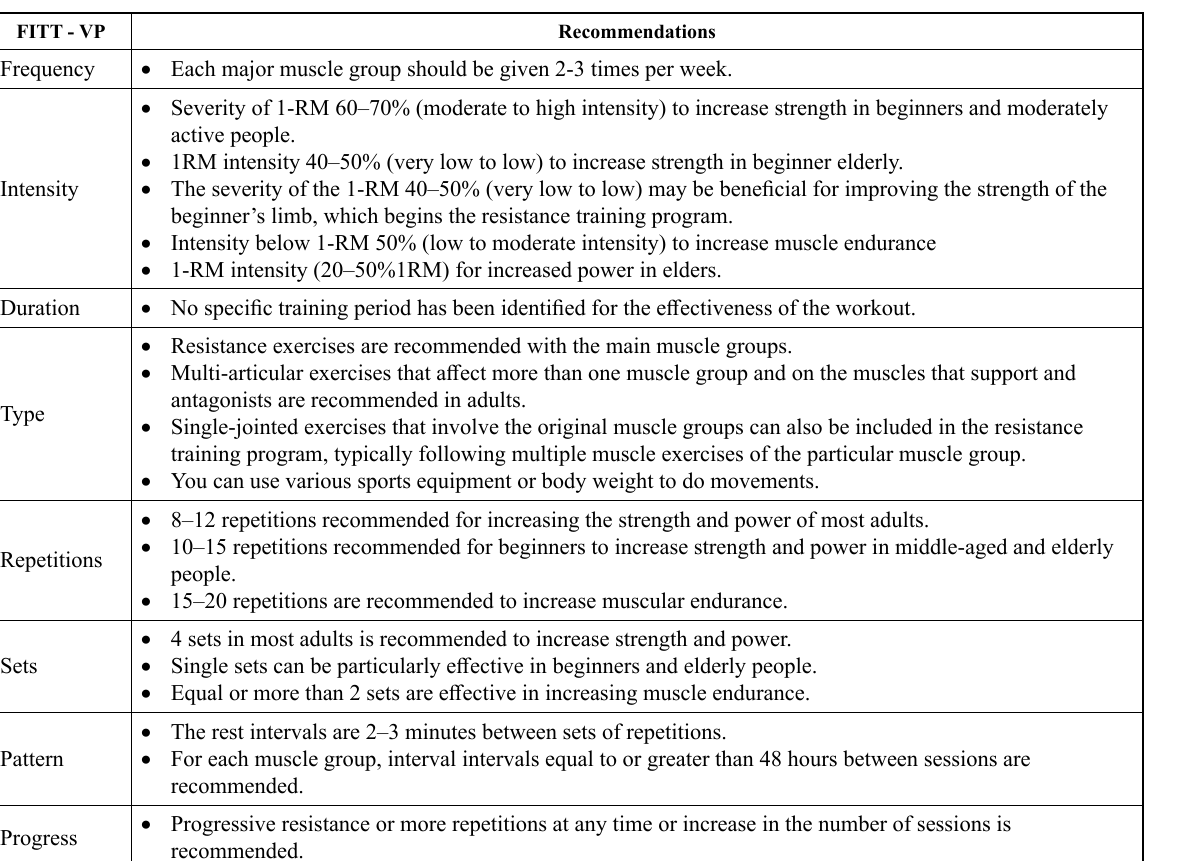
Table 4. Recommendations based on resistance training